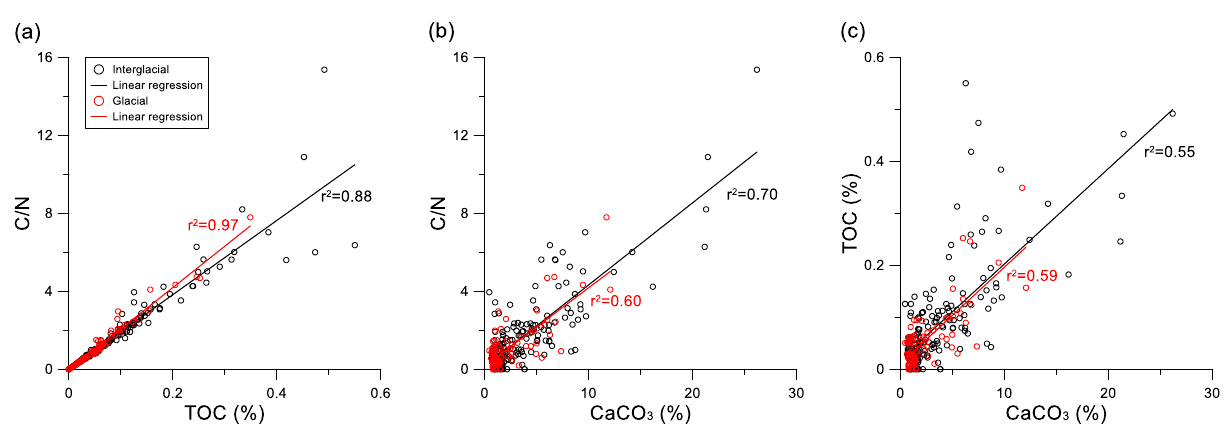
Figure 3. Cross-plots between the geochemical results of core ARC5-MA01. ( a ) C/N vs. TOC, ( b ) C/N vs. CaCO 3 , and ( c ) TOC vs. CaCO 3 with their correlation coefficient (r 2 ) during the glacial (red) and interglacial (black) periods,